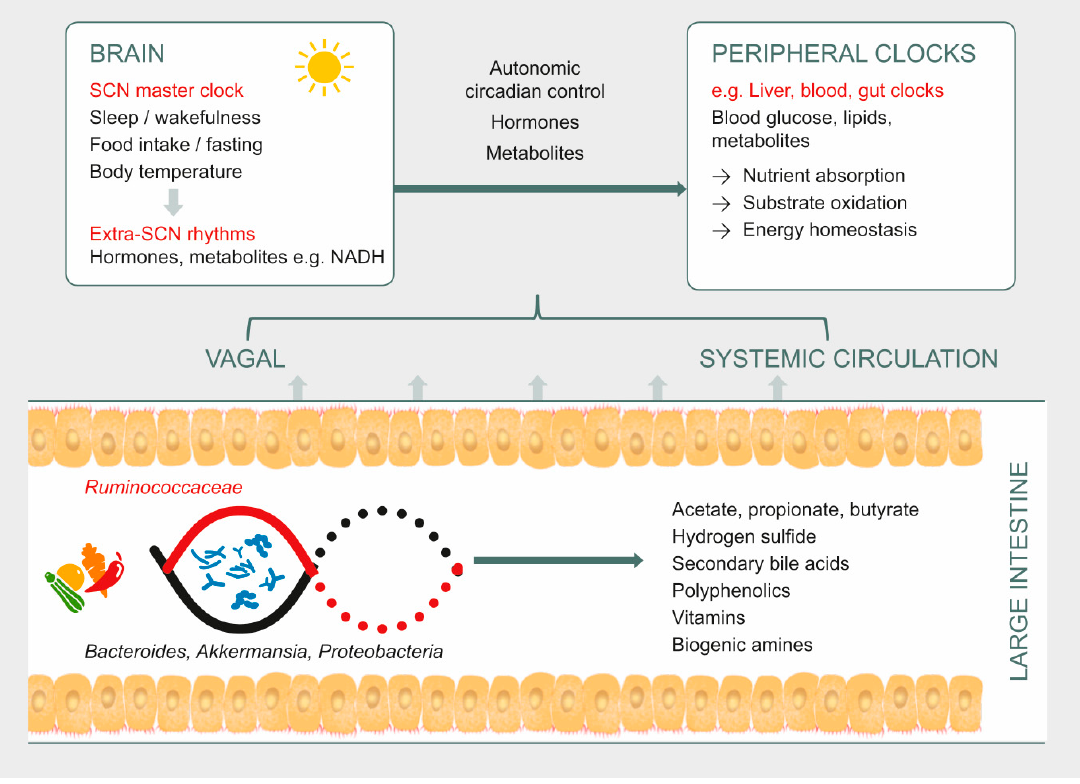
Figure 2. Potential mechanism of gut microbiota interactions in the circadian–metabolic axis. Host behavior, sleep, and diet control gut bacteria, which in turn show changes in terms of microbial composition and functional genome in a rhythmic manner. Circadian rhythms may be affected by microbial metabolites such as butyrate, secondary bile acids, and microbially synthesized vitamins, and potentially disrupted by hydrogen sulphide. The immediate effects on energy resources for colonic epithelial cells, and peripheral effects on substrate oxidation via systemic circulation potentially impact energy